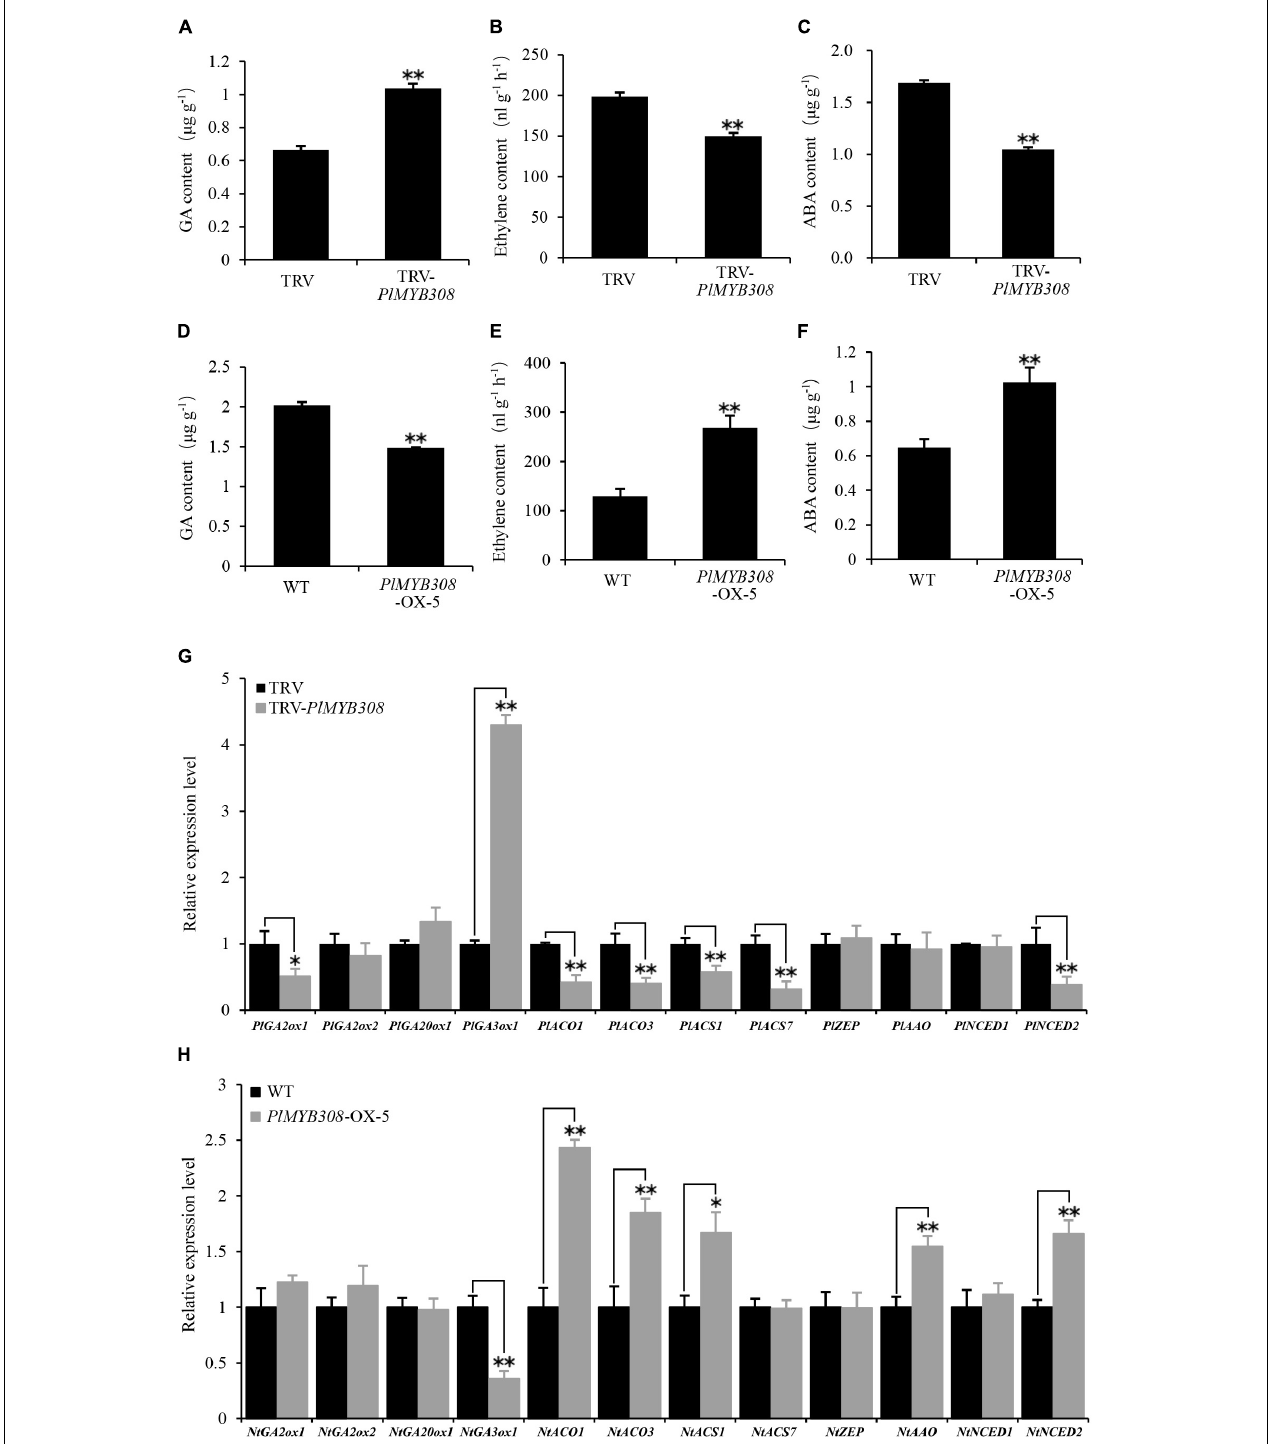
FIGURE 4 | Effect of PlMYB308 overexpression and silencing on GA, ethylene, and ABA production and hormone biosynthesis-related genes expression levels. (A–C) Content of GA, ethylene, and ABA in TRV empty vector- and TRV- PlMYB308 -infiltrated herbaceous peony petal disks. GA, ethylene, and ABA production was measured at D4 after infiltration. (D–F) Content of GA, ethylene and ABA in wild-type and PlMYB308 -overexpressing transgenic tobacco line (OX-5). GA, ethylene, and ABA production was measured at D5 after anthesis. (G) The petal disks were sampled for gene expression analysis at D4 after infiltration with TRV empty vector and TRV- PlMYB308 . PlUB was used as an internal control. Relative expression levels were normalized to the empty vector control. (H) The tobacco flowers were sampled for gene expressions analysis at D5 after anthesis. NtEF-1 α was used as an internal control. Relative expression levels were normalized to the WT. Error bars show SD of the means of three biological replicates. Asterisks indicate statistically significant differences (* P < 0.05, ** P < 0.01, Student’s t -test).